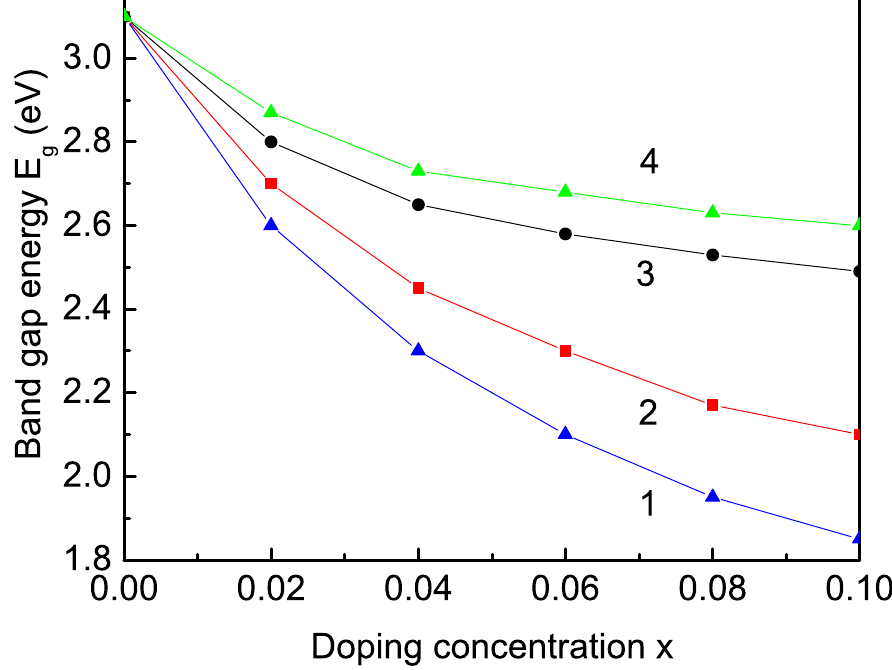
Figure 3. Dependence of the band-gap energy E g for T = 300 K on the ion-doping concentration x in a TiO 2 NP ( N = 20 shells) for (1) Co, (2) Fe, (3) Mn, and (4)